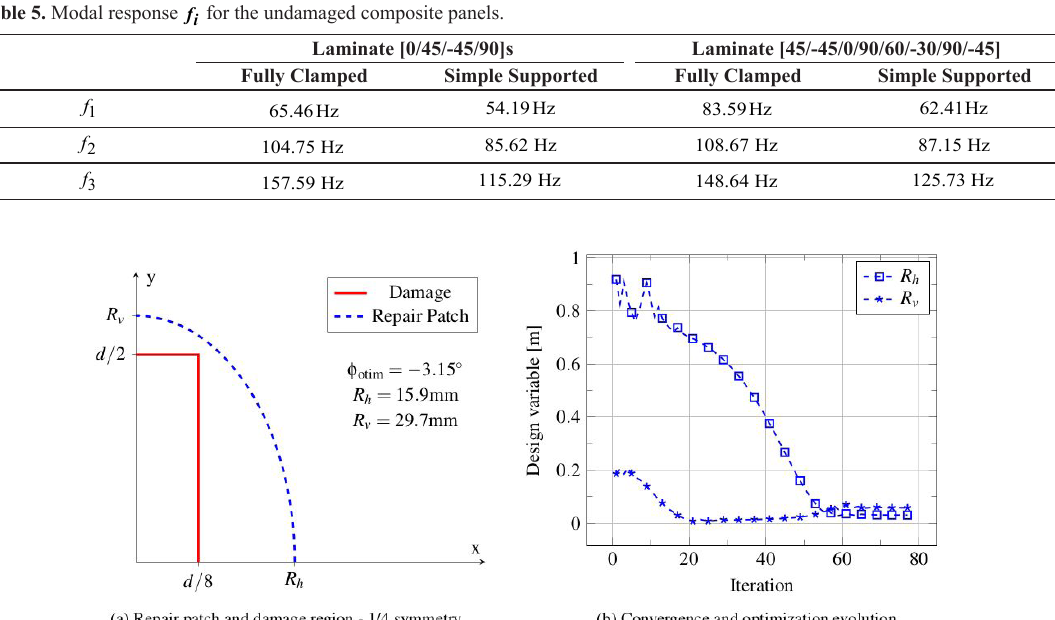
Figure 1. Elliptical repair patch - FC with symmetric stacking